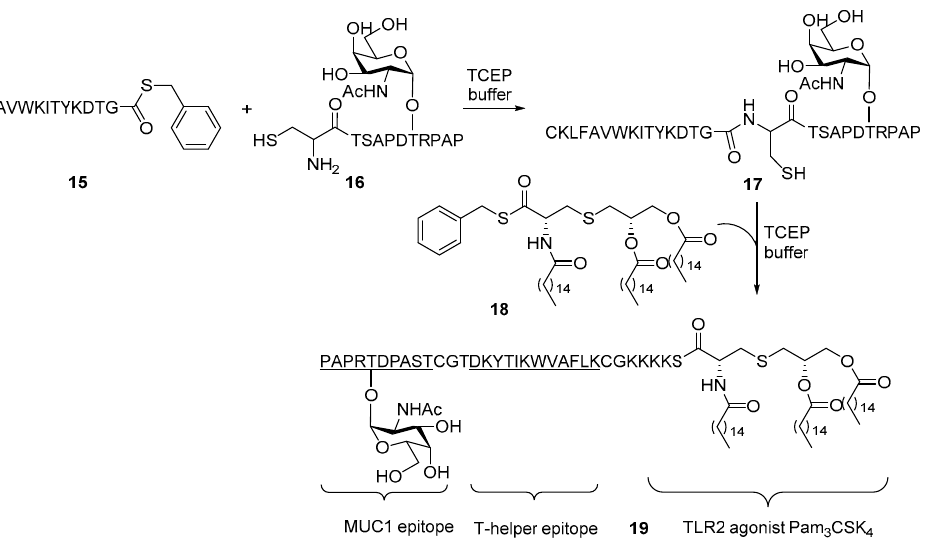
Scheme 3. Synthesis of MUC1 glycopetide-based three-component conjugate vaccine 19 containing the